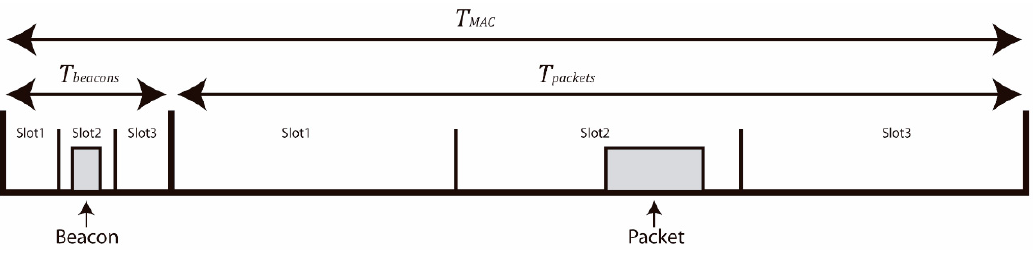
Figure 2. MAC frame timing scheme.